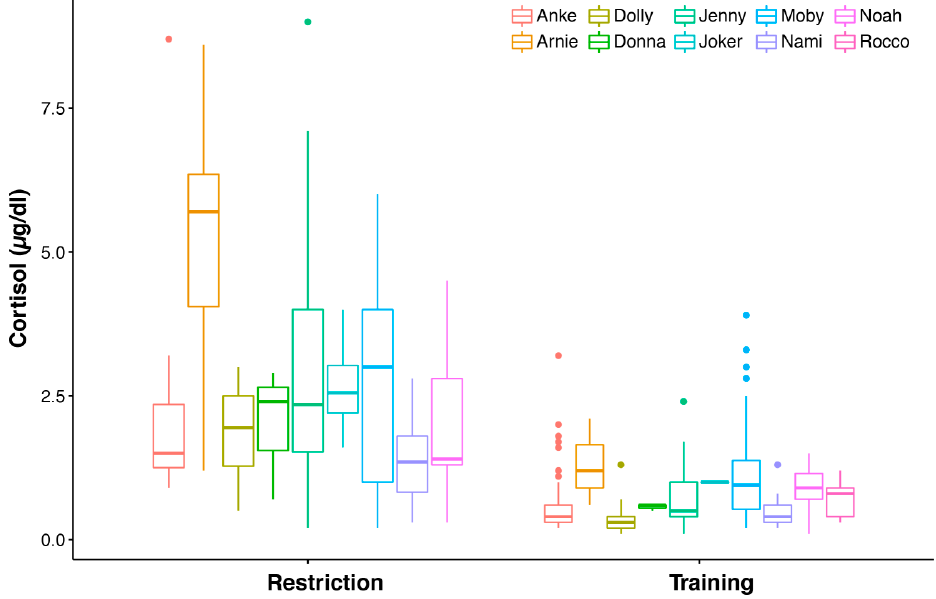
Figure 5. Blood cortisol values for five female and five male dolphins for the treatments restriction, and